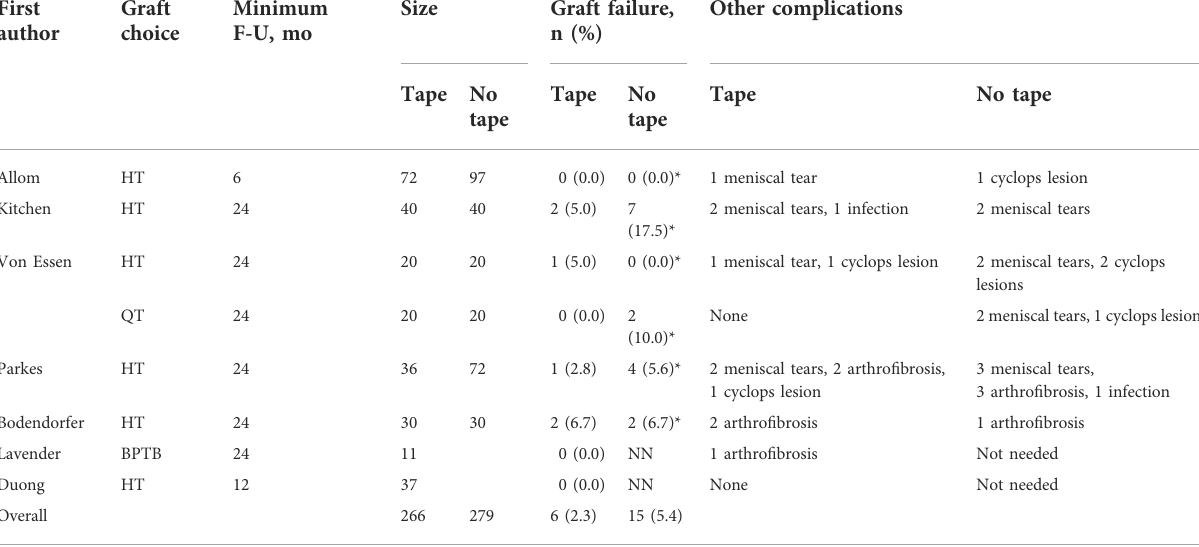
TABLE 8 Graft failure and other complications between anterior cruciate ligament reconstruction with or without suture tape